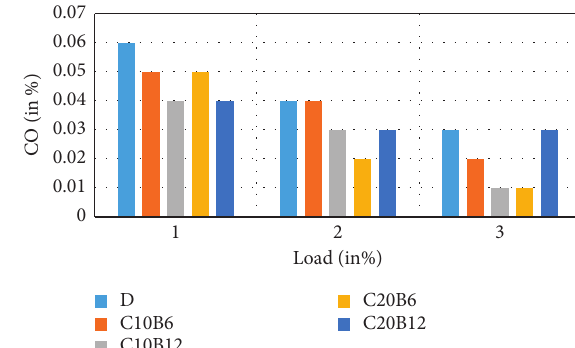
Figure 7: NOx versus load for PMME.